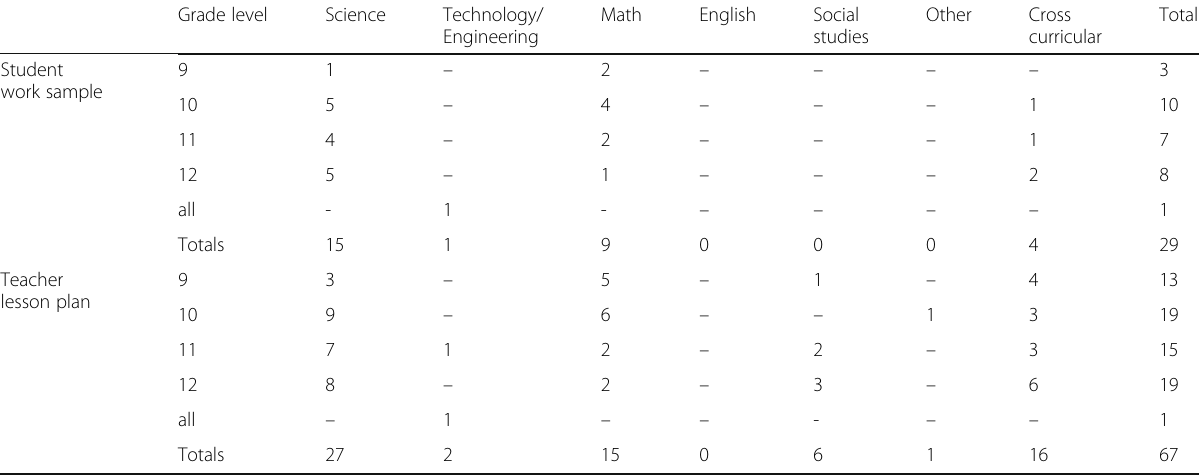
Table 3 Number of student work samples and teacher lesson plans by content matter and grade